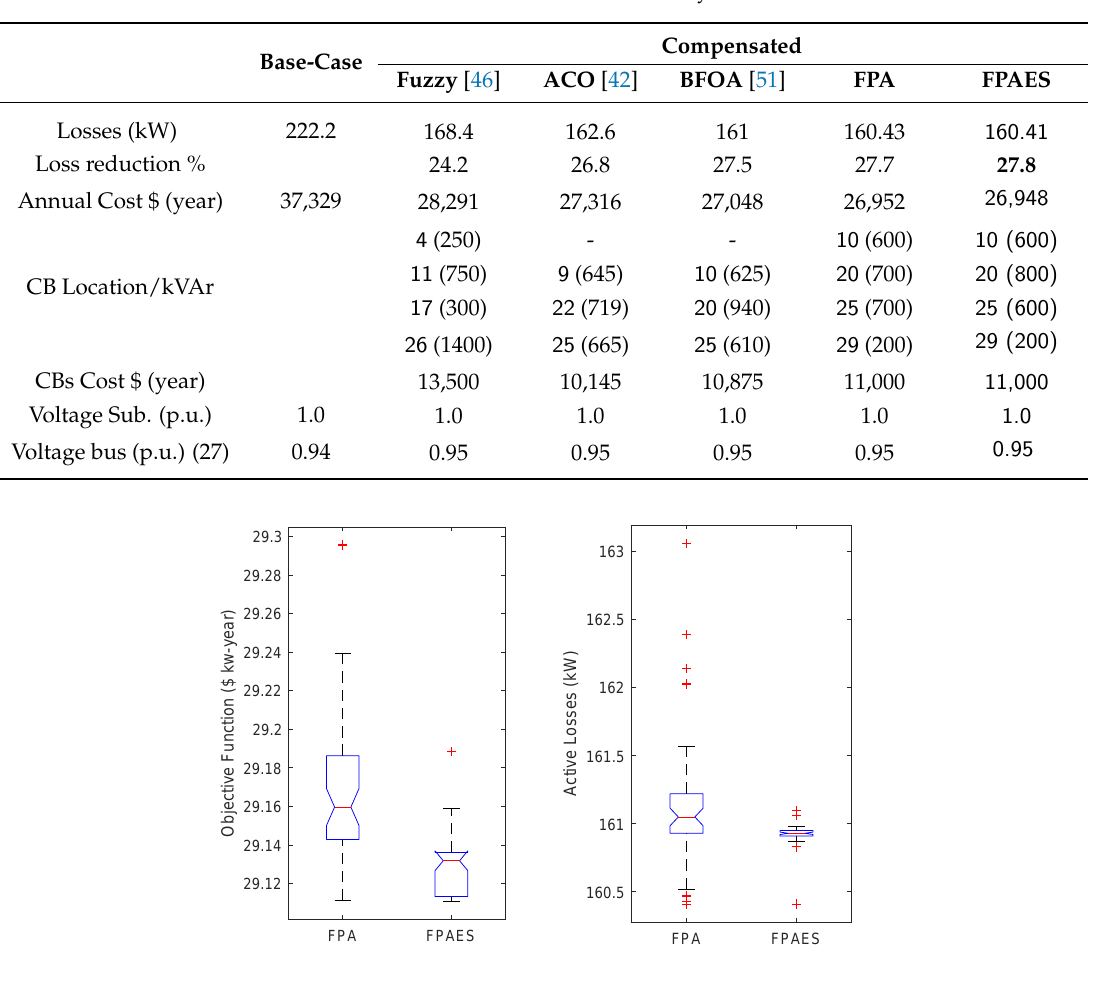
Figure 6. Box plot of 50 simulations, 34-bus system (the median is represented in the central mark, and the ’+’ symbol denotes the outliers)